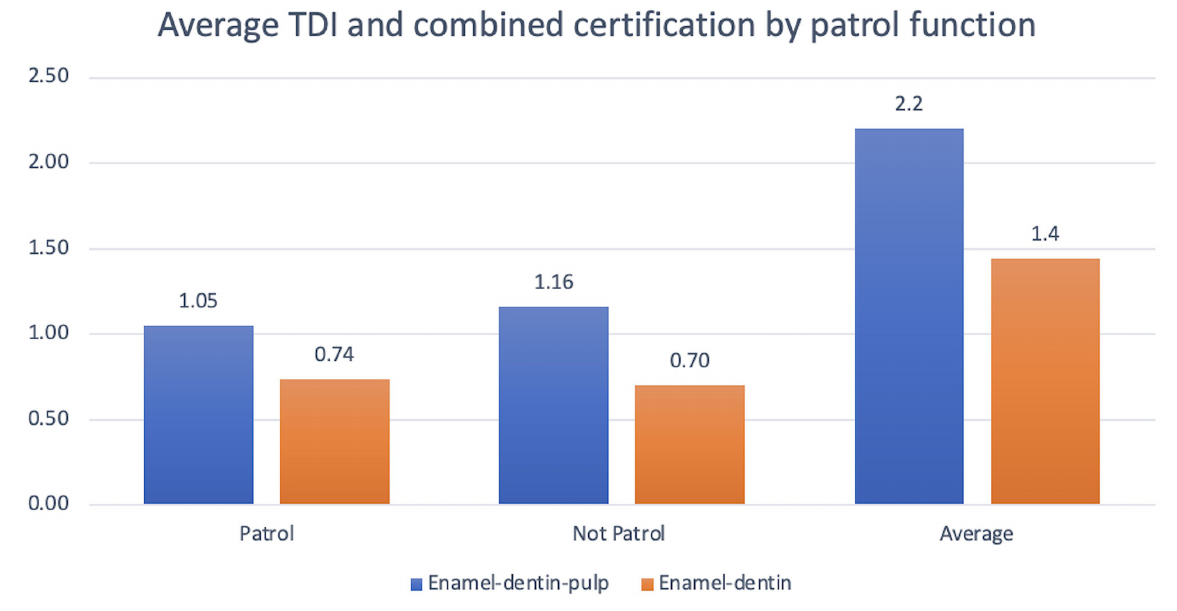
FIGURE7 Graphical projection of average TDI and combined certification by patrol function. Note that both patrol and non-patrol MWDs had a higher frequency of enamel-dentin-pulp fractures vs. enamel-dentin fractures. There was no statistical significance between patrol function and increased risk of enamel-dentin-pulp